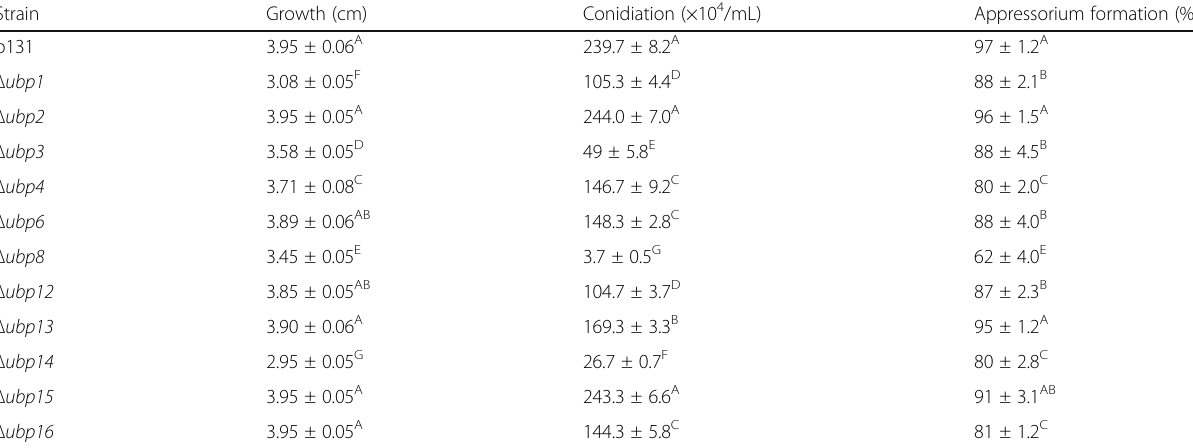
Table 1 Comparison of biological phenotypic characteristics among strains Strain